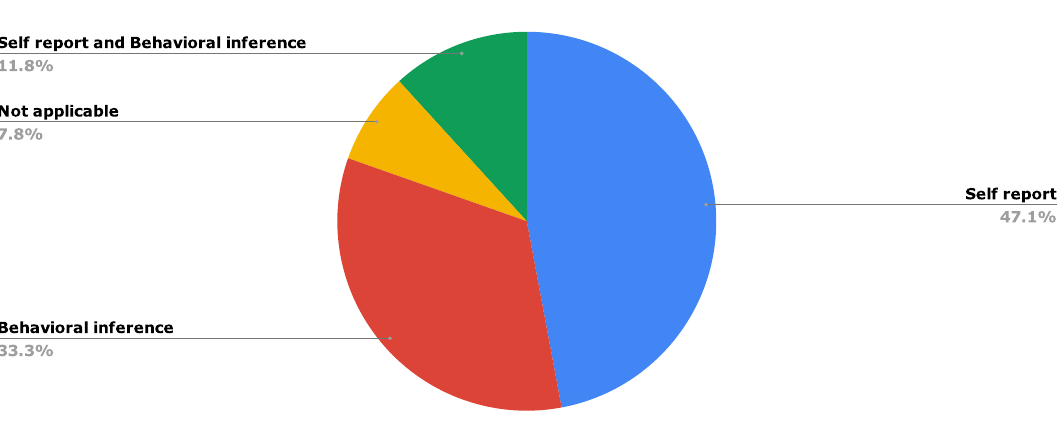
Figure 7. Commonly used inference validation